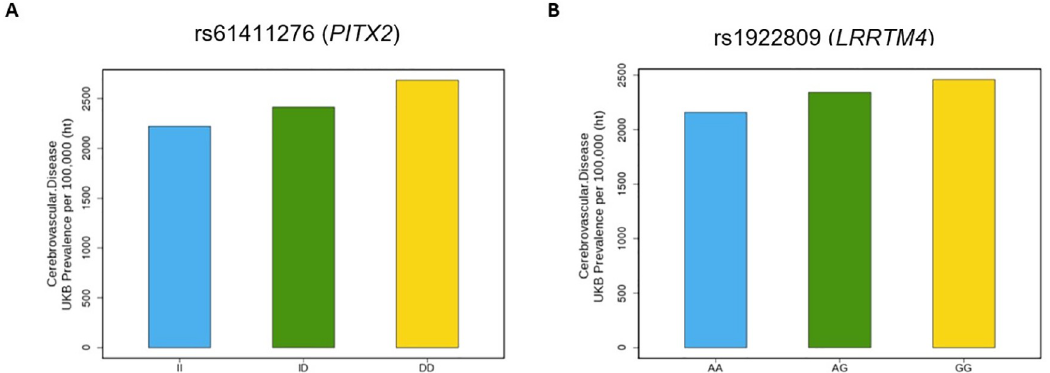
Fig 2. Single nucleotide polymorphisms associated with cerebrovascular disease in the UK Biobank. (A) Prevalence of CeVD increases with PITX2 variant rs61411276 status (2,222 per 100,000 for wild type; 2,414 per 100,000 for heterozygotes; 2,682 per 100,000 for homozygotes; p-value 2.6 x 10 − 9 ; OR 1.1 per D allele). (B) Prevalence of CeVD increases with LRRTM4 variant rs1922809 status (2,159 per 100,000 for wild type; 2,341 per 100,000 for heterozygotes; 2,458 per 100,000 for homozygotes; p-value 4.3 x 10 − 8 ; OR 1.08 per G allele). OR: Odds ratio; PITX2: Paired like homeodomain 2; LRRTM4: leucine rich repeat transmembrane neuronal 4.